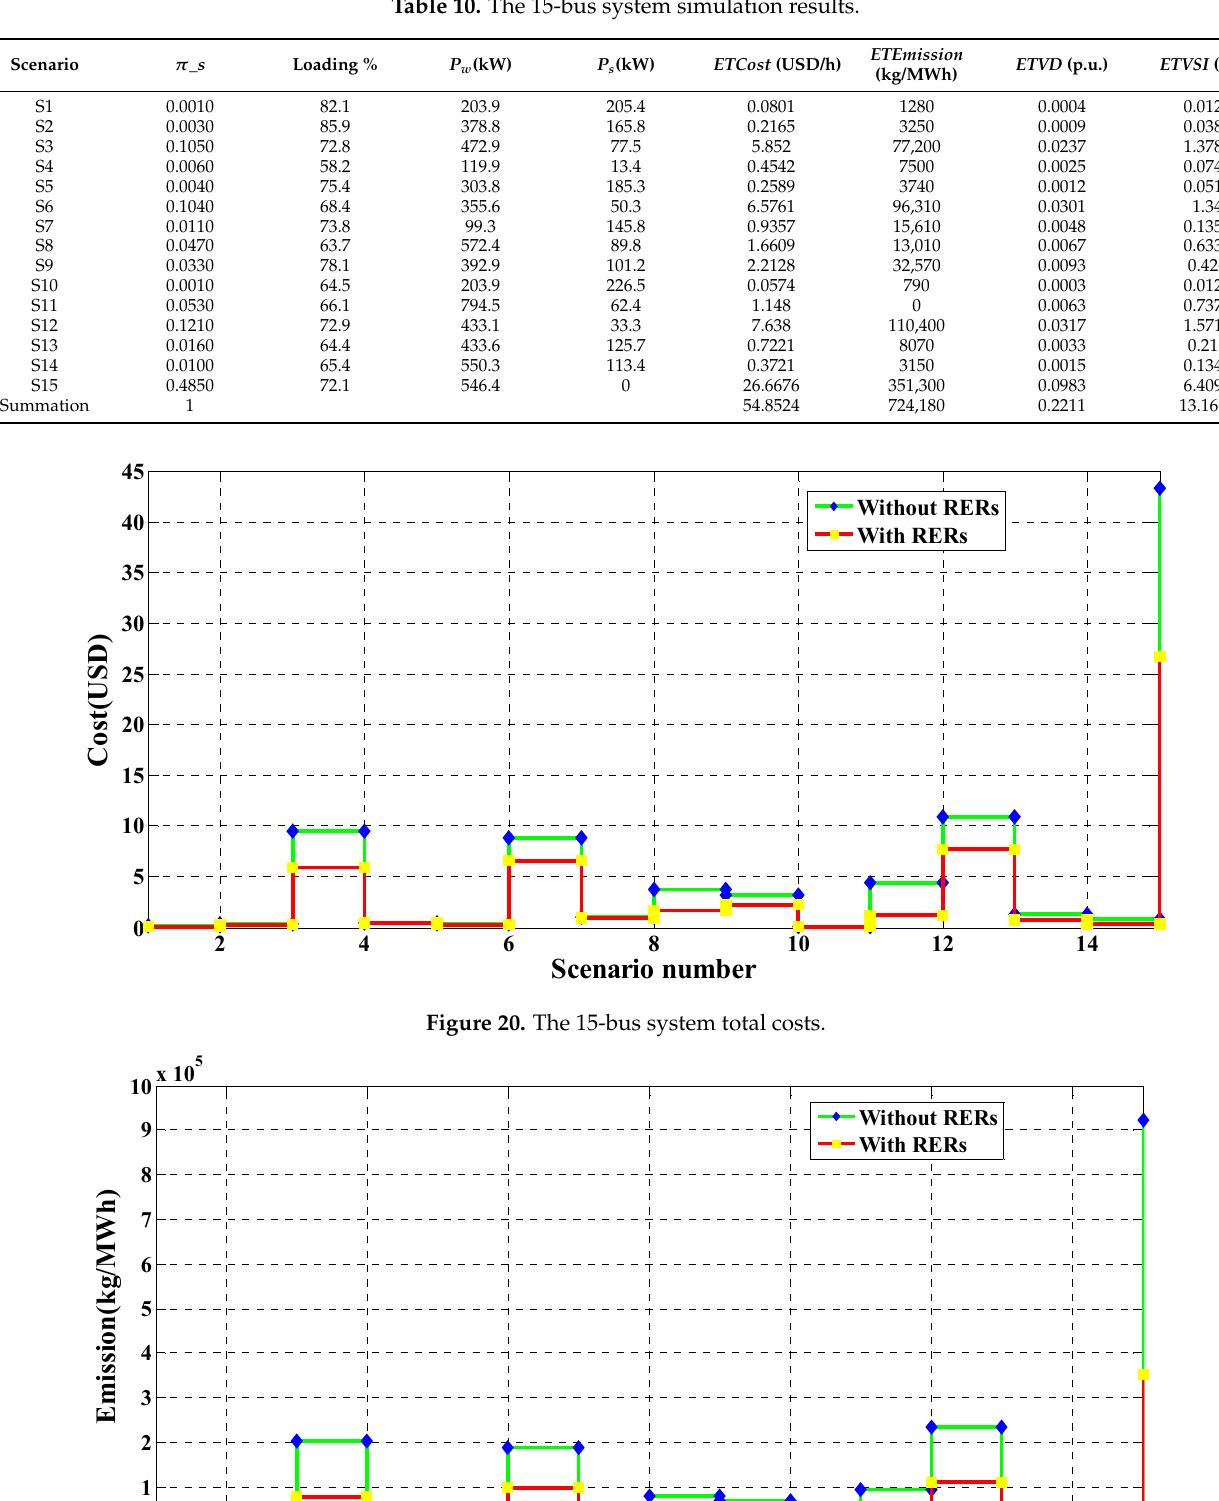
Figure 22. The 15-bus system VDs.